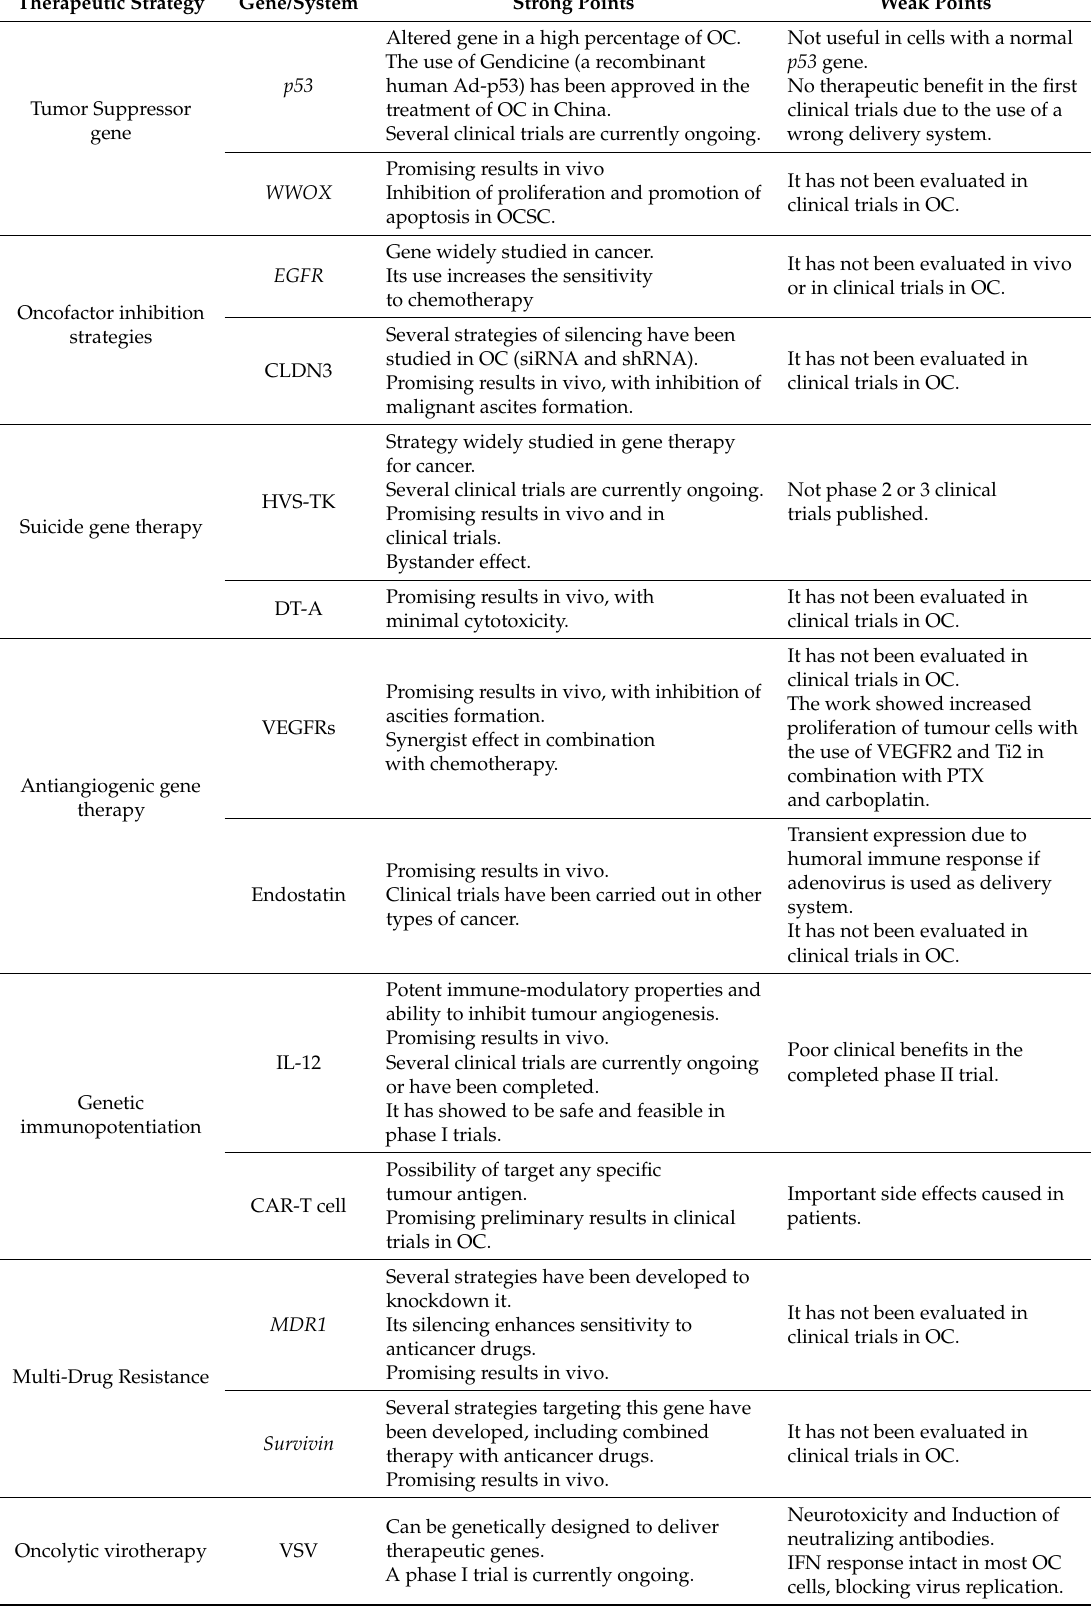
Table 1. Strengths and weaknesses of various gene therapy strategies for ovarian cancer treatment. Therapeutic